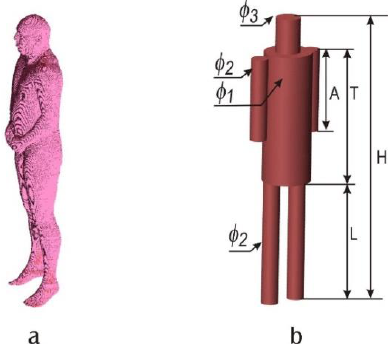
Figure 3. Human body model: ( a ) NMR Hershey; ( b ) simplified 6 cylinder model: H = 1800 mm, A = 500 mm , L = 790 mm, T = 836 mm, ϕ 1 = 110 mm, ϕ 2 = 160 mm, ϕ 3 = 315 mm.